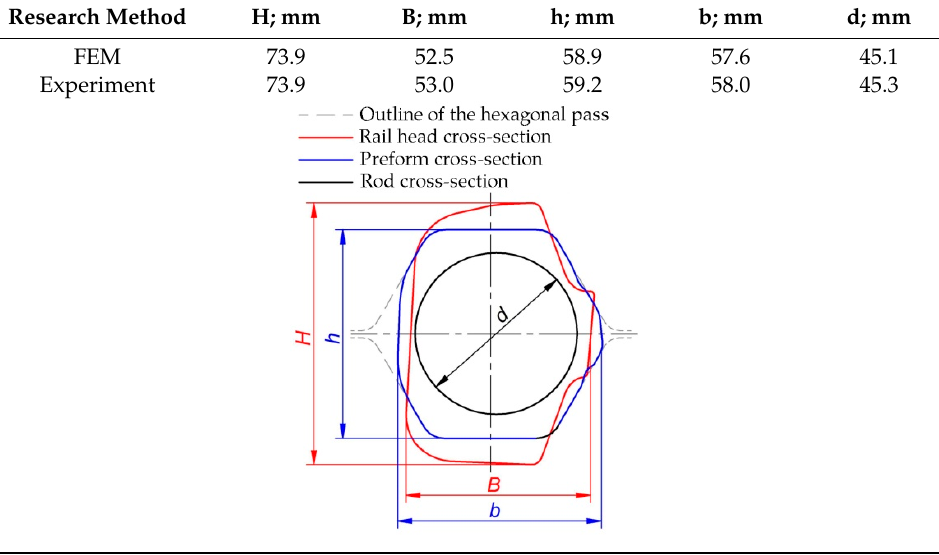
Figure 16. Changes in the cross-sectional shape of the rail head during rod rolling: ( a ) head cut off from a scrapped rail; ( b ) preform formed in the hexagonal pass of the longitudinal mill; ( c ) rod rolled in a helical pass of the skew mill. Table 3. Geometric parameters of rolled rods and preforms.